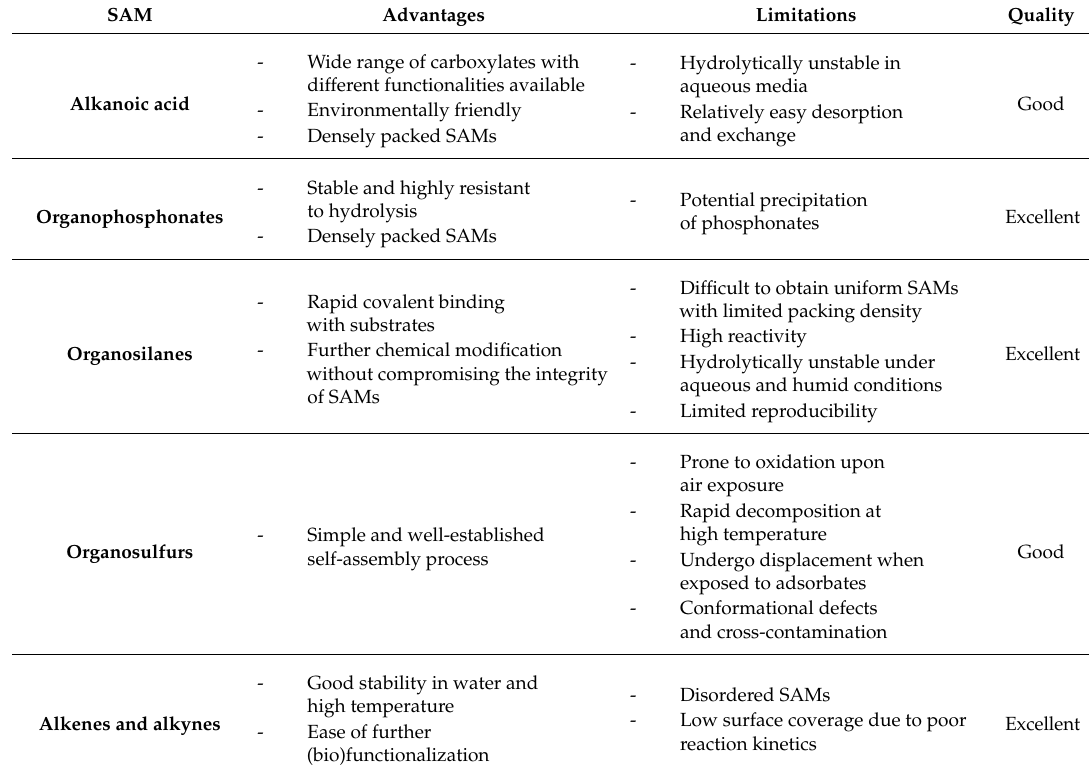
Table 1. Comparison of properties of self-assembled monolayers (SAMs) of different